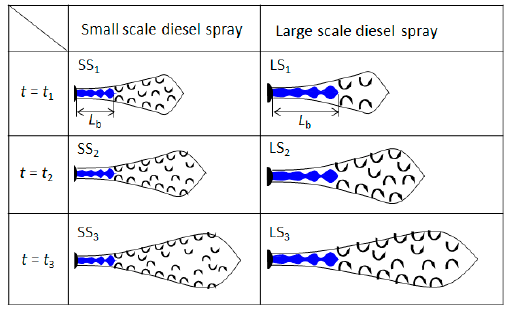
Figure 2. Small- and large-scale diesel sprays.